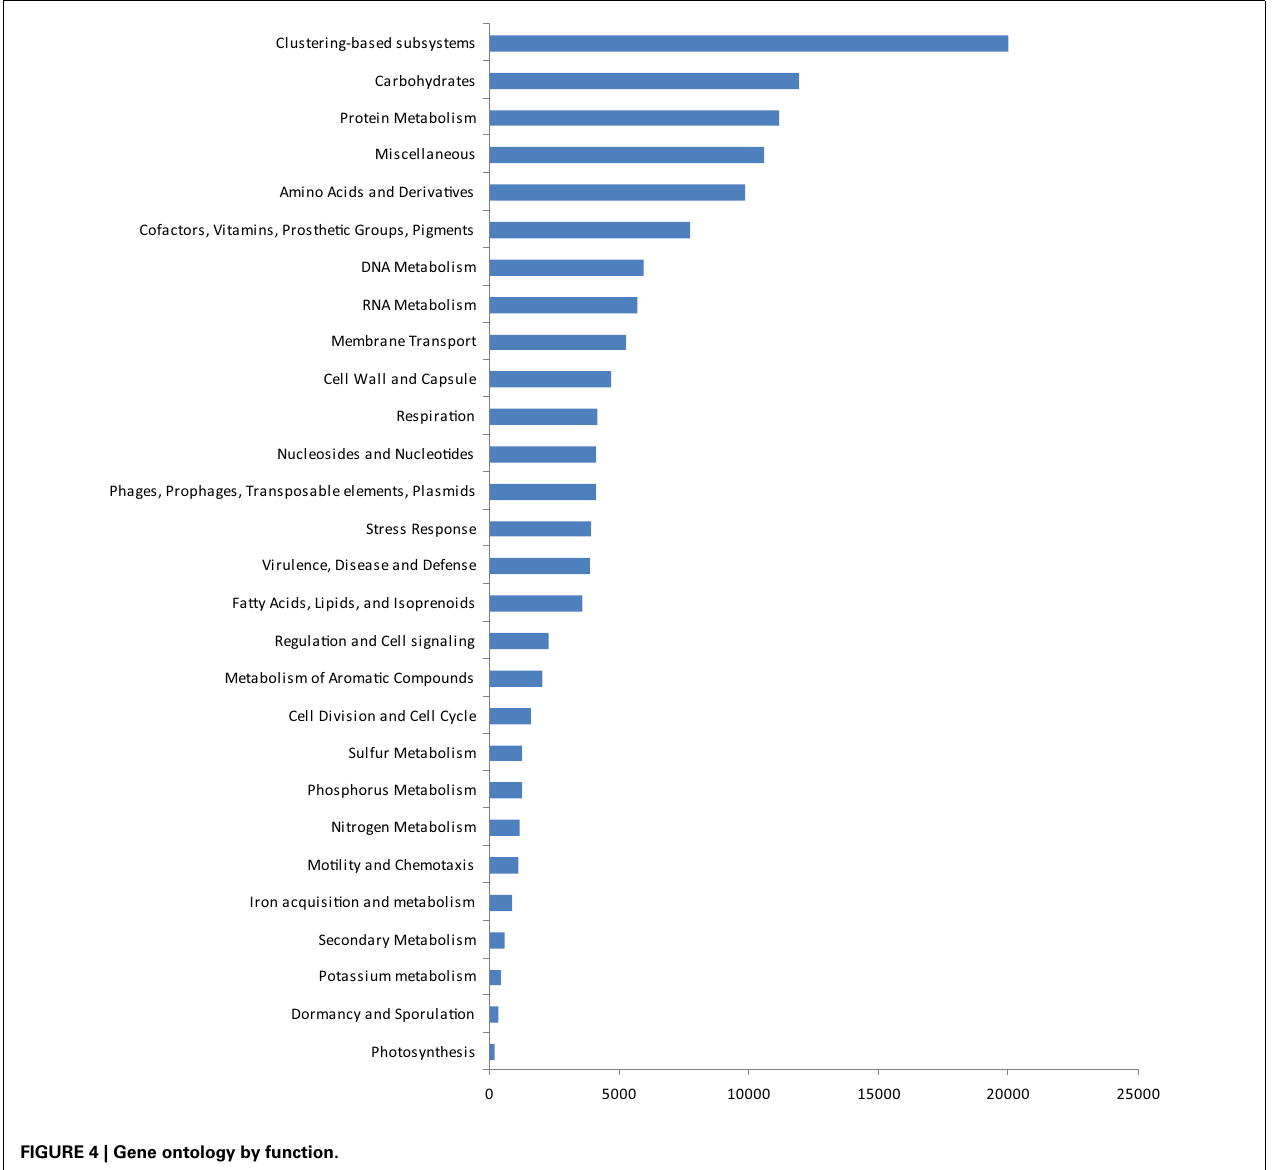
FIGURE 4 | Gene ontology by